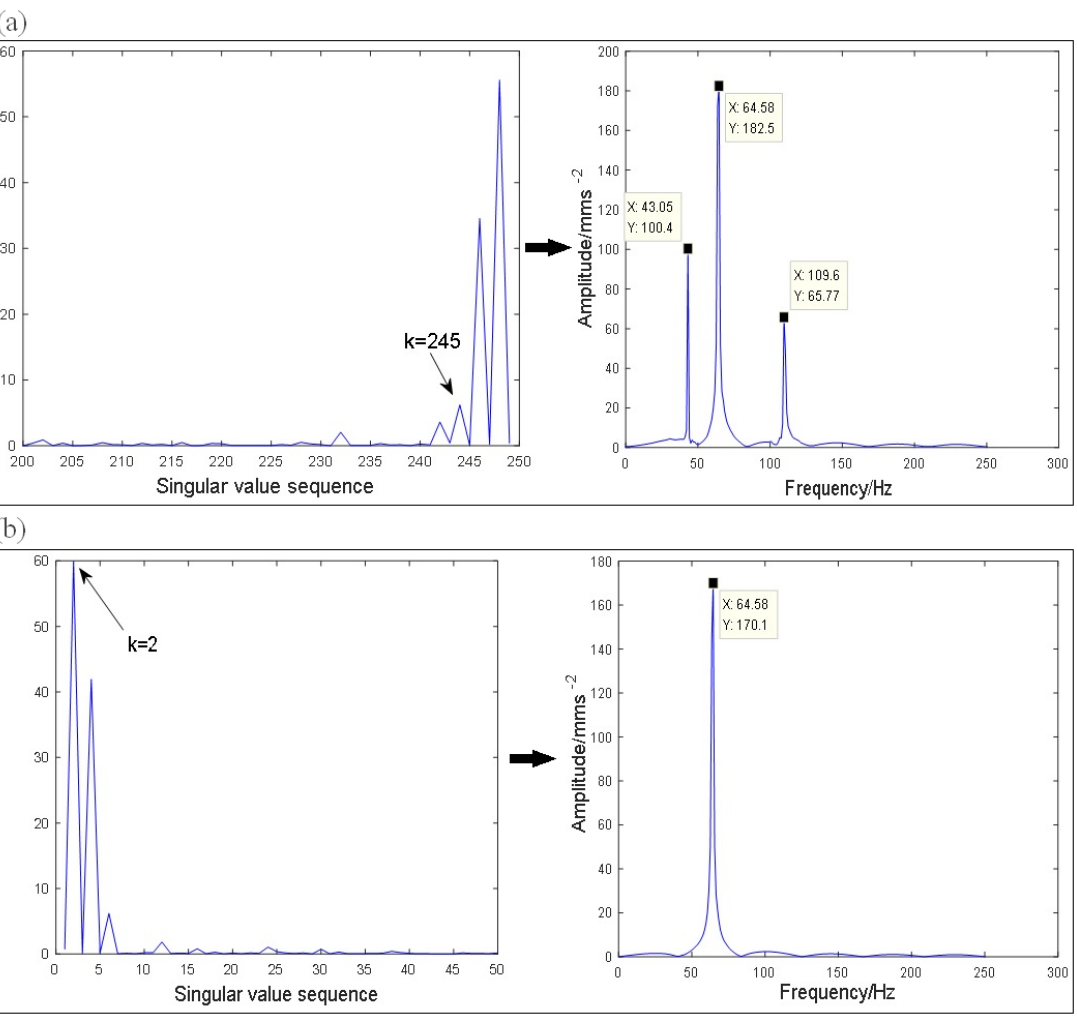
Figure 1. Comparison of frequency spectrums: ( a ) without noise and ( b ) with noise (SNR = 1).